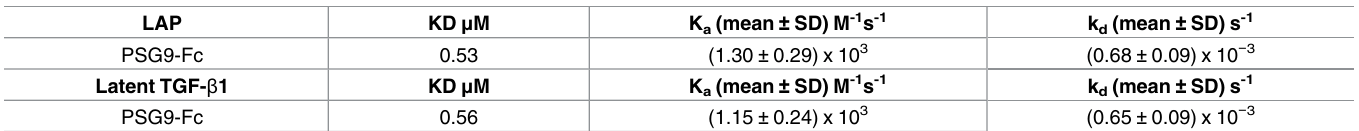
The kinetic data shown in Fig 2 for the interaction of PSG9-Fc with SLC and LAP were fit using a 1:1 Langmuir binding model for the estimation of the association ( k a ) and dissociation rates ( k d ) and dissociation constant (KD = k d / k a